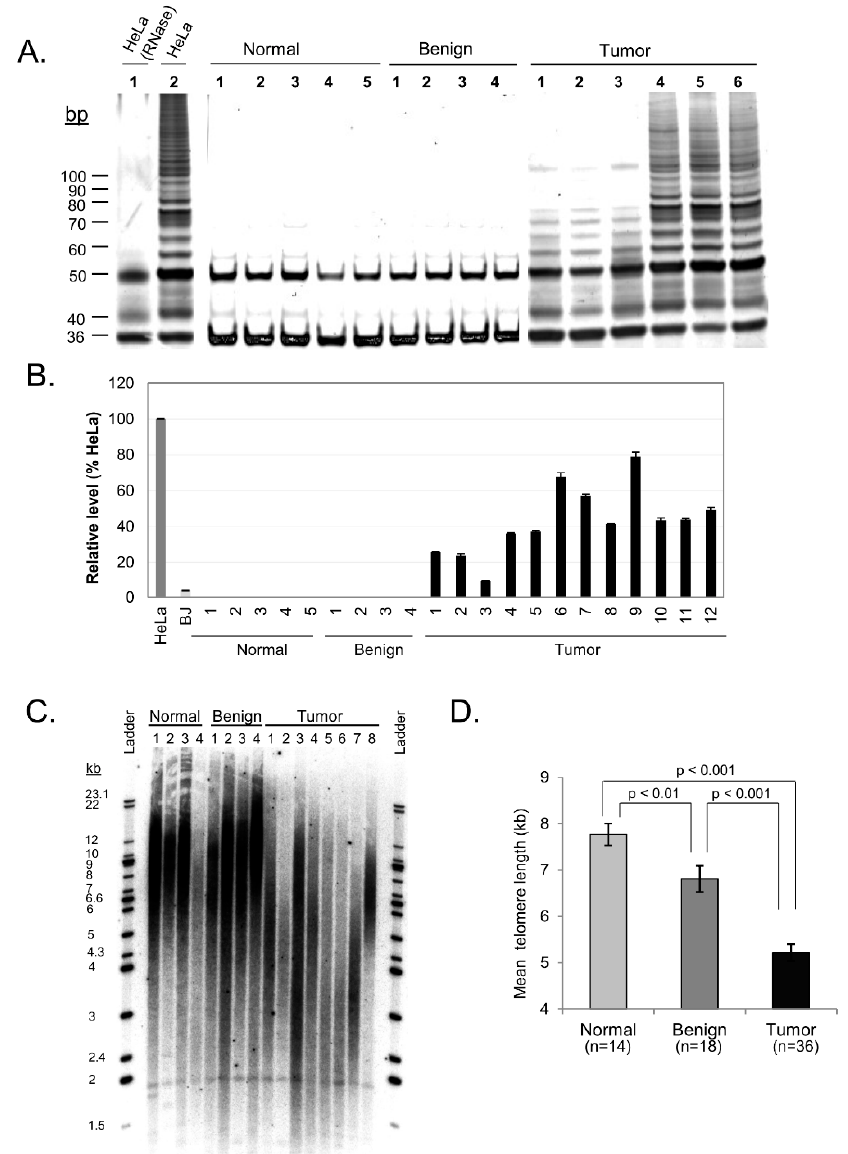
Figure 3. hTERT, telomerase, and telomere length profiles of ovarian carcinoma tissue samples. ( A ) Representative samples with telomerase activity in ovarian carcinoma. Fresh lysates of HeLa cells were used as positive control for telomerase activity while heat treated HeLa cells with inactivated telomerase serve as negative control. ( B ) Representative samples of hTERT expression levels in ovarian carcinoma quantified. HeLa and BJ cells were used as positive and negative controls respectively. ( C ) Representative Southern Blot of telomere length comparing normal, benign and tumor ovarian tissue. ( D ) Quantified mean telomere length (kb) of normal, benign and tumor tissue samples (mean ± SE). Standard t-test analysis is